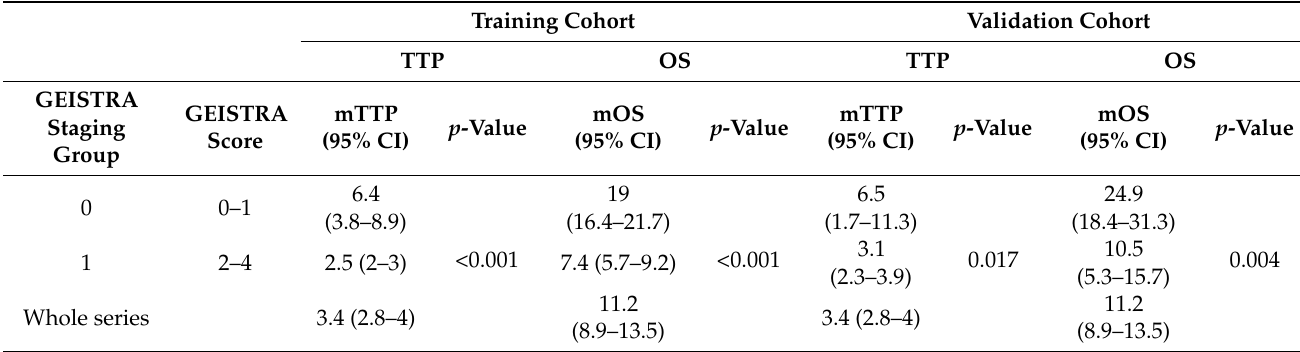
Table 5. Correlation between GEISTRA score and time-to-event outcomes from trabectedin therapy in the training and validation